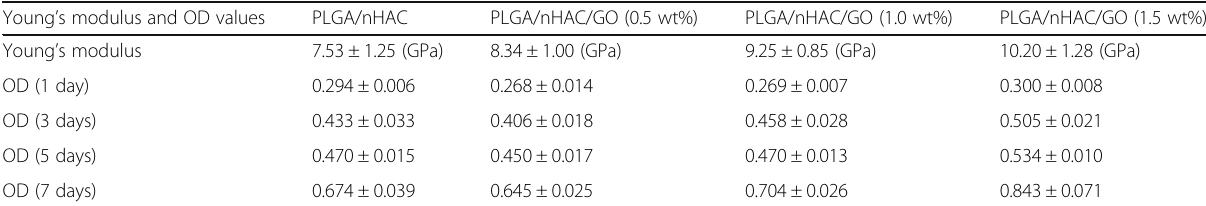
Table 1 Young ’ s modulus and OD values of different PLGA/nHAC/GO scaffolds Young ’ s modulus and OD